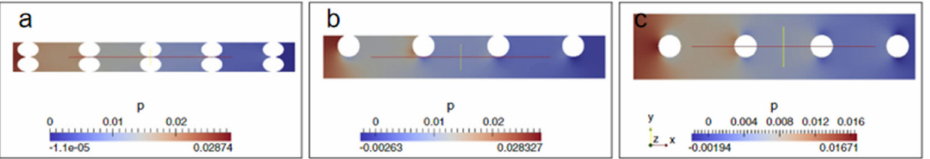
Figure 17. Pressure (in kPa) color maps on a z-normal plane through center of the domain [33]. Reproduced with permission from Elsevier, 2013. ( a ) spacer type 1; ( b ) spacer type 2; ( c ) spacer type